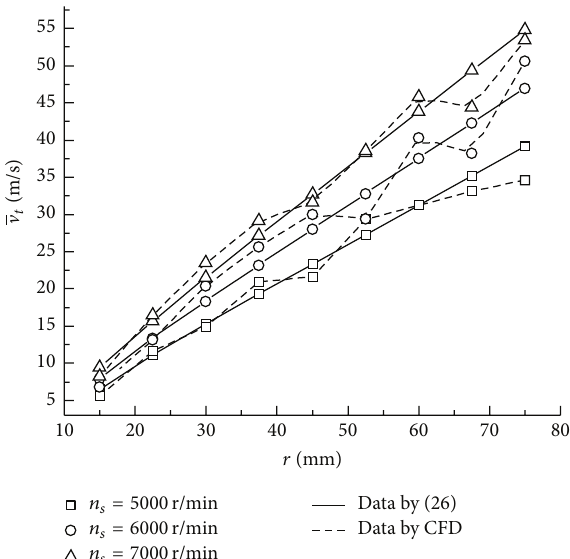
Figure 8: Comparison of data by (26) and data by CFD.